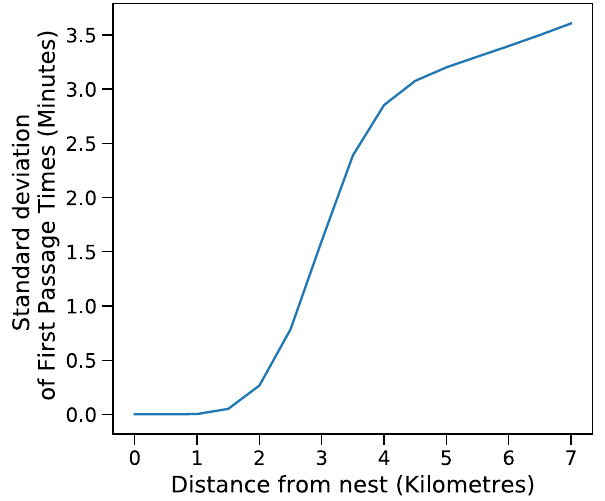
Figure 8. Standard deviation of first passage times for WH1Br at different distances from its nest. At a given distance, the standard deviation is obtained over all the movement directions. The region of steepest increase represents areas around human settlements. The standard deviation saturates after a certain distance since the bird has crossed the human settlements along the directions where they